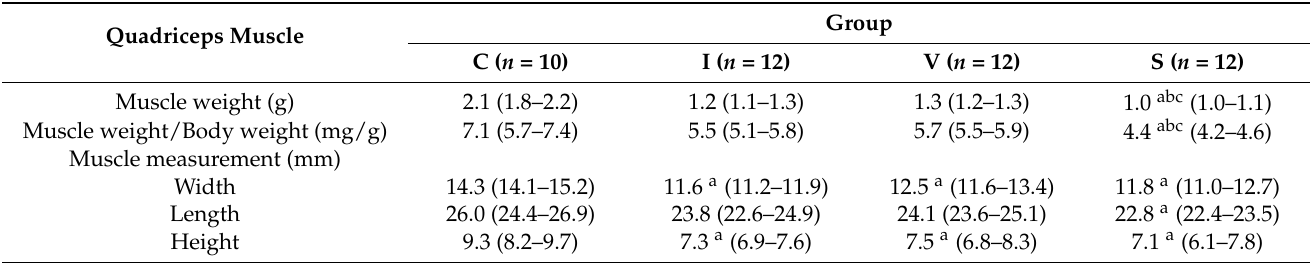
Table 5. Quadriceps muscle weight and quadriceps muscle measurements on Day